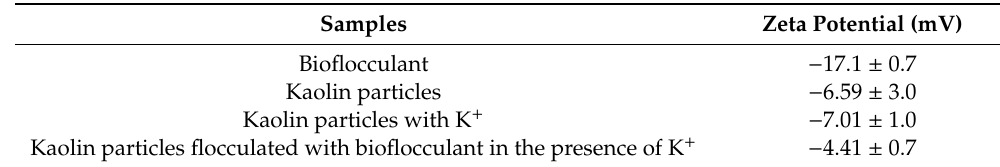
Table 4. Zeta potential of di ff erent samples.